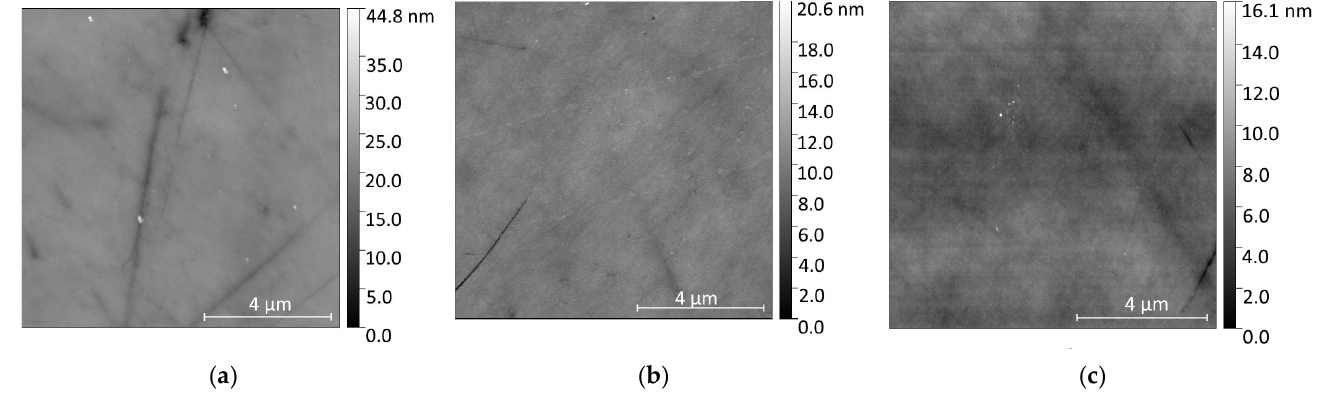
Figure 11. Surface topography of the deposited layer when using the HiPIMS power supply for the deposition times of ( a ) 5 min, ( b ) 10 min and ( c ) 15 min.